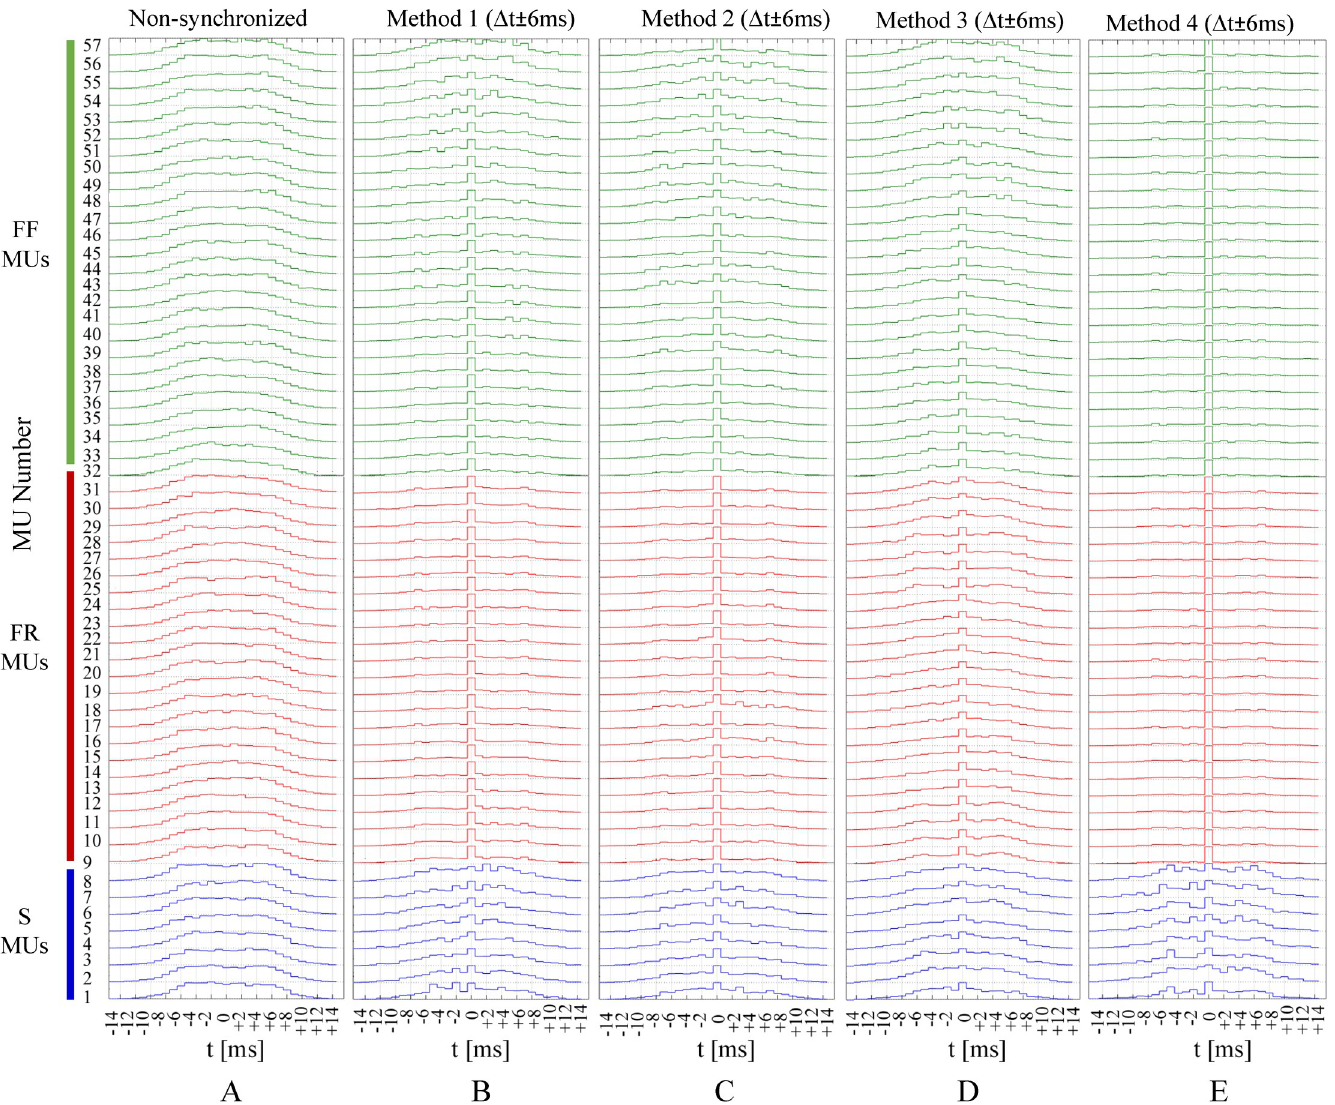
Fig 6. Cross interval histograms of all 57 MU firing patterns for the NS basic model and the four methods of MUs’ synchronization using Δ t ± 6 ms. The cross- interval histograms are depicted with maximal bin normalization, considering a bins width of 1 ms within a bin interval of ± 15 ms. The amplitude of the central bin, presenting a minimal cross-interval difference of ± 0.5 ms, is proportional to the derived index of synchronization ( CISI